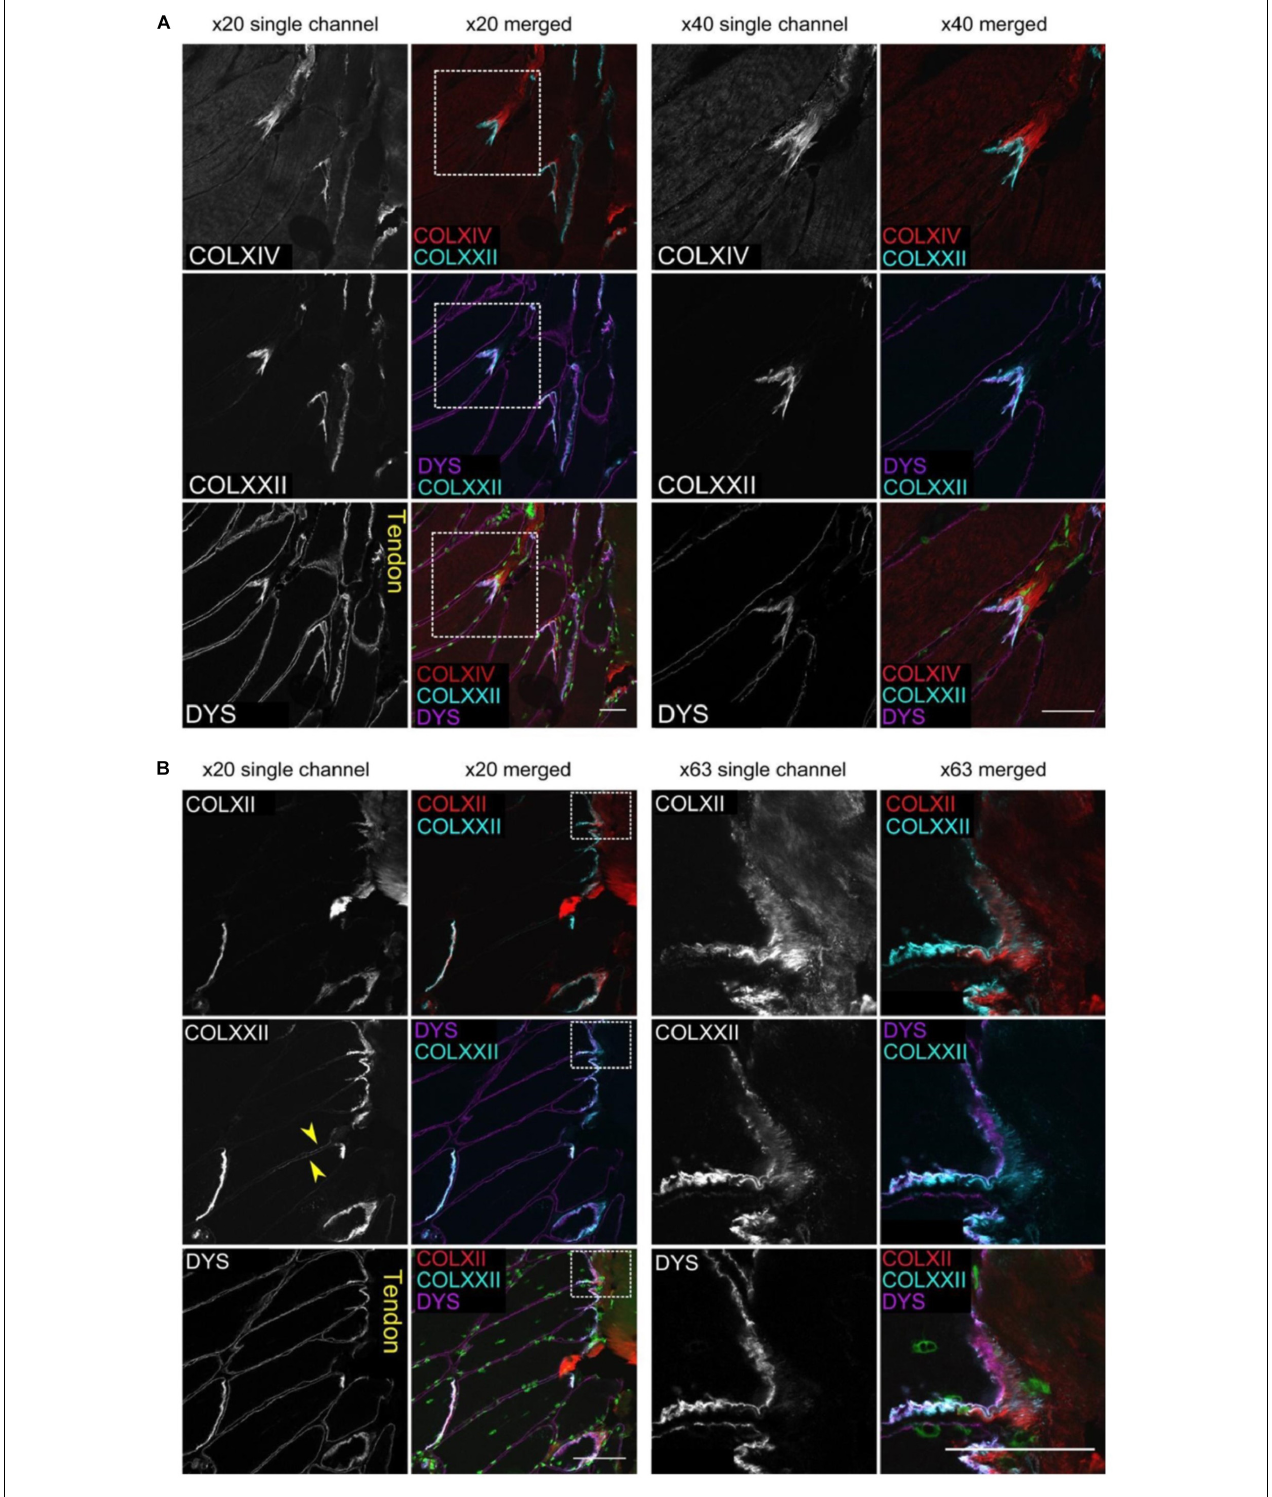
FIGURE 3 | The figure shows multiple images of human gracilis MTJ stained with immunofluorescent antibodies against collagen XXII, dystrophin and either collagen XIV (A) or XII (B) . The muscle fibers show to the left and the tendon to the right. Dystrophin is located closest to the muscle fiber with collagen XXII immediately outside the muscle membrane. Collagen XIV and XII are present next to collagen XXII on the outside of the muscle fiber. Scale bars are 50 µ m. The figure is from Jakobsen et al. (2017), used by permission.